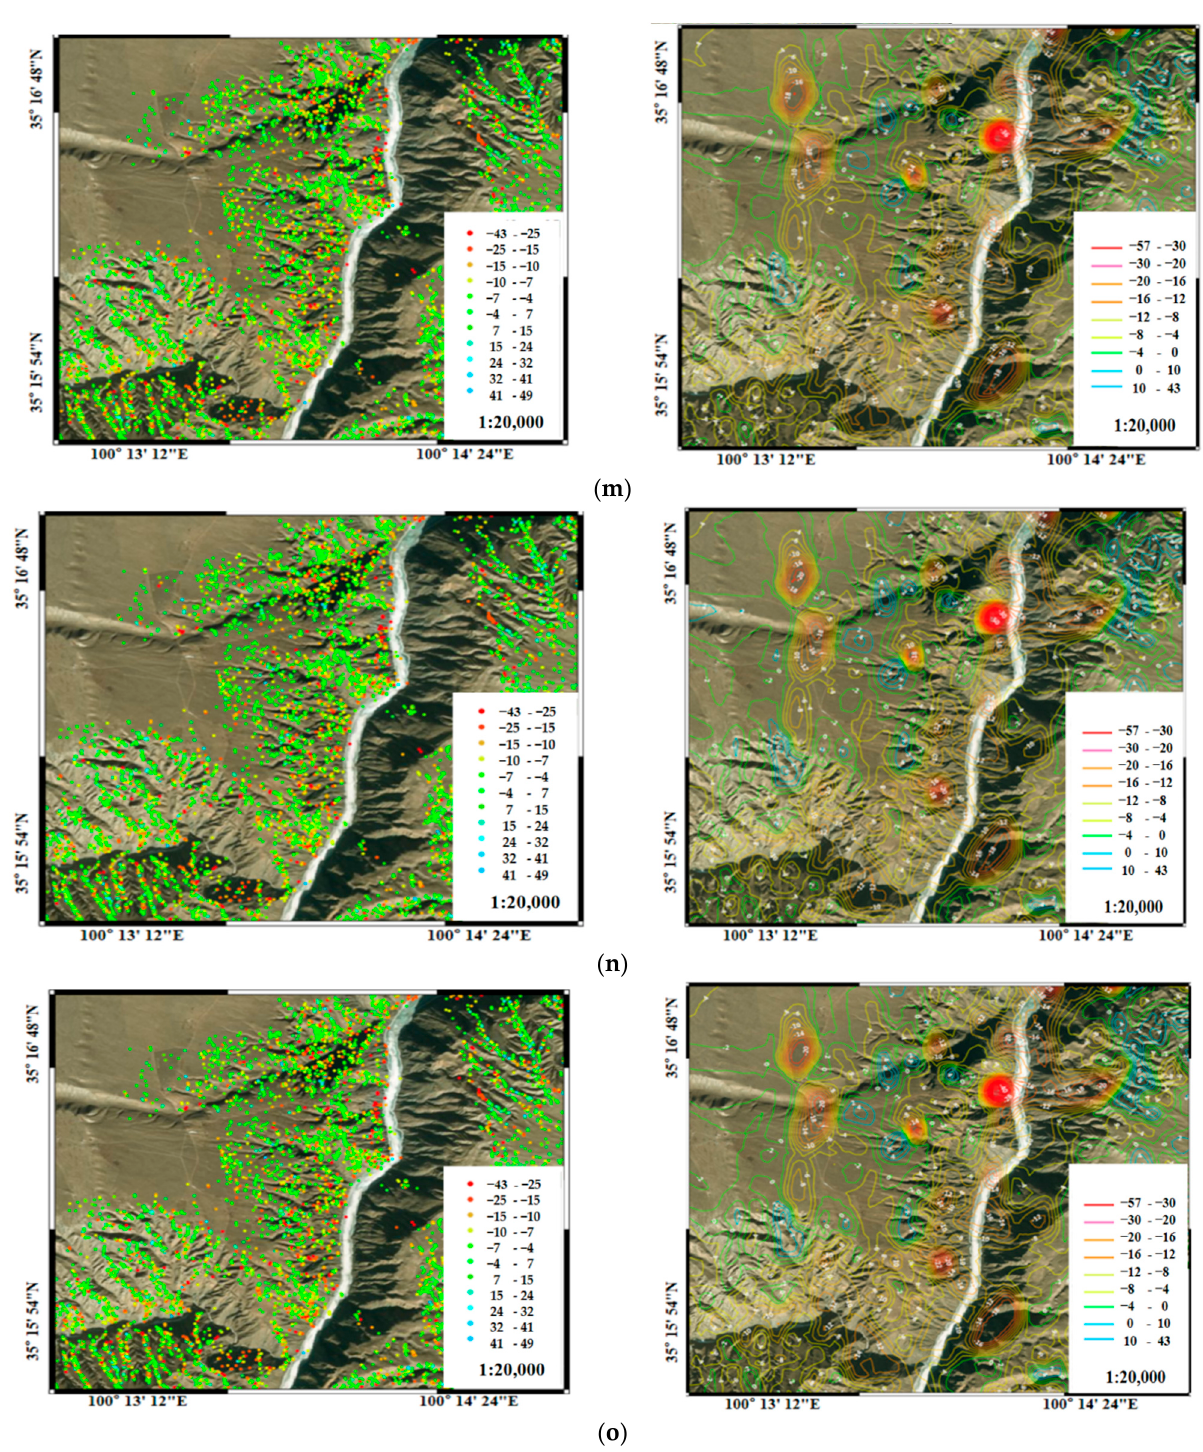
Figure 11. Cumulative deformation distribution map of the slope. ( a ) As of January 2015; ( b ) As of May 2015; ( c ) As of August 2015; ( d ) As of December 2015; ( e ) As of March 2016; ( f ) As of August 2016; ( g ) As of November 2016; ( h ) As of April 2017; ( i ) As of August 2017; ( j ) As of February 2018; ( k ) As of June 2018; ( l ) As of October 2018; ( m ) As of February 2019; ( n ) As of May 2019; ( o ) As of August 2019.